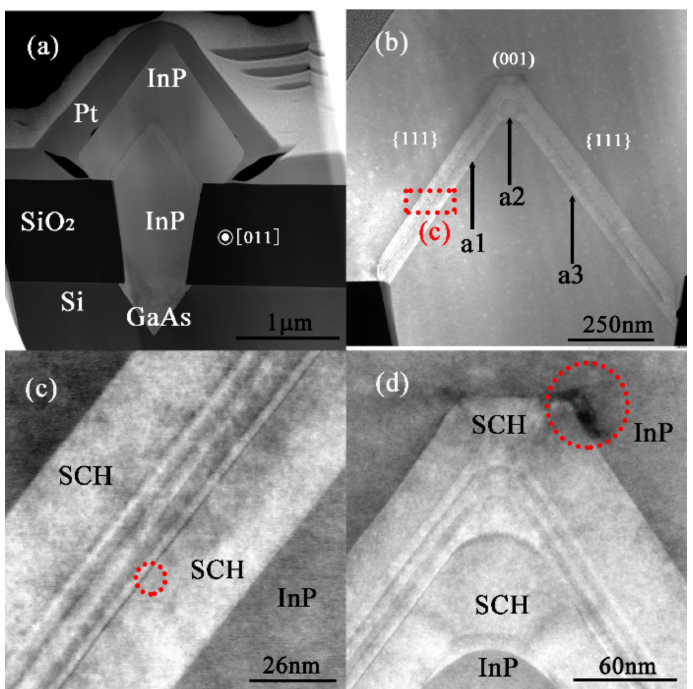
Figure 3. ( a ) Cross-sectional STEM images of the SCH–MQW microwire with RRW. ( b ) Cross-sectional STEM images of the SCH–MQW region. The material of the SCH layer and the quantum barriers is InGaAsP, and the material of the quantum wells is InGaAs. ( c ) Magnified TEM image of the marked areas in the red dashed squares in ( b ). ( d ) Magnified TEM image of the top SCH–MQW structure. The thickness of the layers that make up the SCH–MQW structure was also quantified. As shown in Figure 3c,d, the thickness of each layer along the {111} plane is uniform, and the thickness of the layer located in the top region is different from that located in {111} facets. Hence, three positions were selected for measuring the thickness of every layer. Table 1 lists the thickness of the bottom SCH layer, quantum wells, quantum barriers, and the top SCH layer at the corresponding positions. For the bottom SCH layer and each quantum well, the thickness at the top near the (001) facet is much thicker than that at two {111} surfaces. On the contrary, the top SCH layer and the quantum barriers at the top region were thinner than that at two {111} surfaces. For III–V materials grown inside nano-scale trenches, a self-limiting growth profile, with a fixed size of convex {111} facets and the top (001) facets are developed to minimize the total surface energy during the selective area growth [28]. The self-limiting size of the (001) facet of InGaAsP, is smaller than that of InP, but larger than that of InGaAs [29]. Hence, the epitaxy of the bottom SCH layer and the quantum wells exhibited a huge growth preference along the vertical [001] direction to minimize the (001) facet, and the epitaxy of the quantum barriers and the top SCH layer was just the opposite. In addition, the optical confinement factor is calculated by comparing the optical energy in the MQW region with the total energy in the simulated region, and the optical confinement factor of the MQW structure shown in Figure 3a is